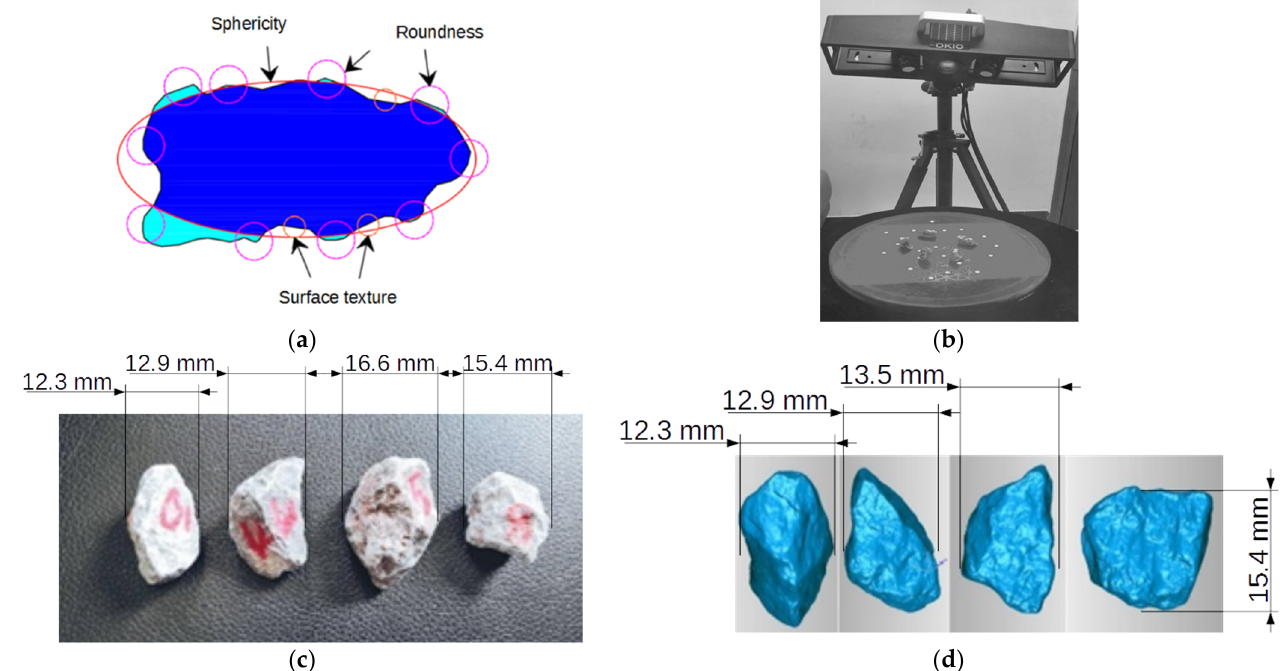
Figure 6. Illustration of particle morphology quantification: ( a ) 3D morphology definition; ( b ) 3D laser scanner used; ( c ) examples of real coarse particles; and ( d ) reconstructed 3D models of example particles.